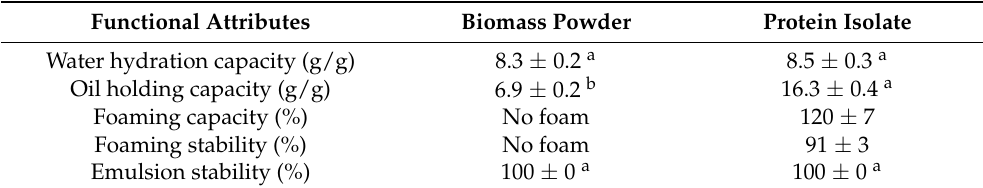
Table 2. Functional attributes of P. maximae biomass powder and protein